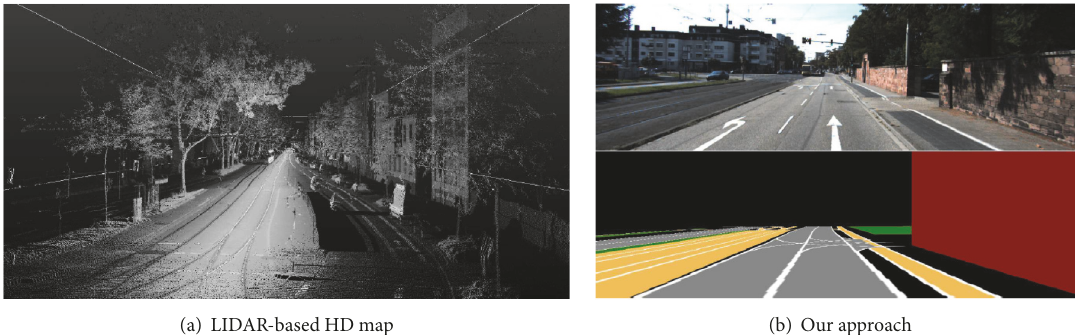
Figure 1: Map-based models: comparison between heavy 3D cloud-based models and light high-level interpretation maps.